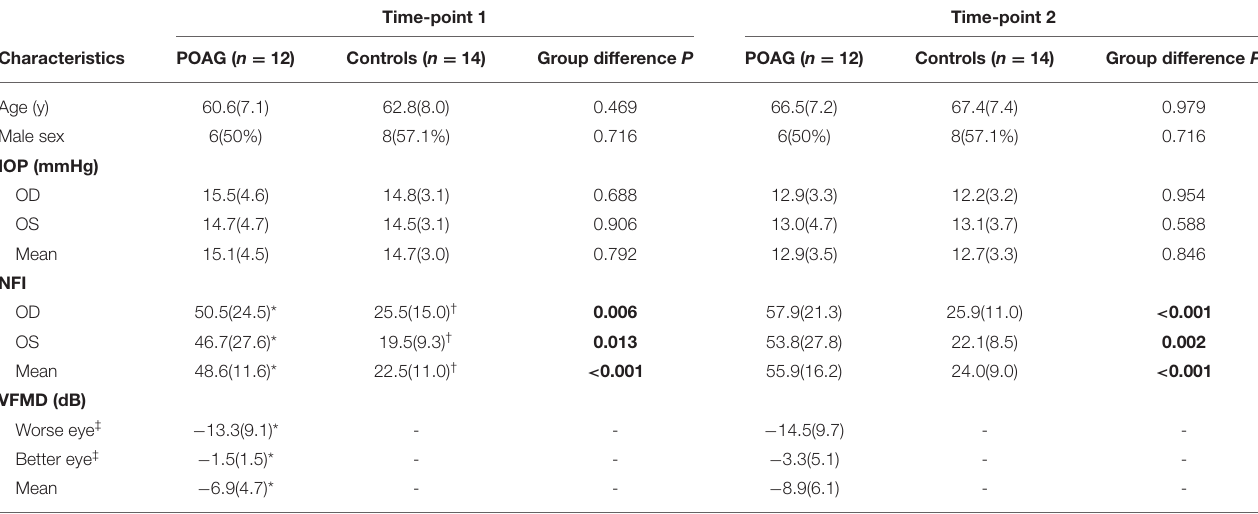
TABLE 1 | Group demographics and clinical characteristics at time-point 1 and time-point 2. Time-point